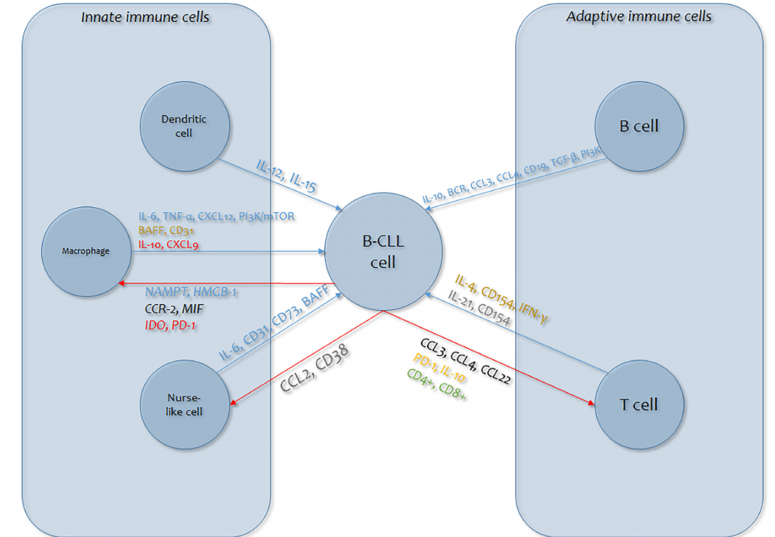
Figure 1. Graphic overview of the mechanisms of cytokine involvement in B-cell lymphocytic leukemia (B-CLL) cellular dynamics (blue arrows: e ff ects of immune cells on B-CLL cells; red arrows: B-CLL cell responses). Cytokines in plain text are those involved in the e ff ects on B-CLL cells (blue: signaling; red: immunosuppression; gold: survival; gray: proliferation); cytokines in italics are those involved in the B-CLL cell response (green: expansion; orange: exhaustion; black: chemoattraction; red: immunosuppression; blue: pro-tumor skewing; gray: immune evasion). CCL: chemokine (C-C motif) ligand; CD38: Custer of Di ff erentiation; IL: Interleukin PD-1: Programmed cell death protein 1; MIF: Macrophage migration inhibitory factor; CCR-2: C-C chemokine receptor type 2; NAMPT: Nicotinamide phosphoribosyltransferase; HMGB: High Mobility Group Box; CXCL: chemokine (C-X-C motif) ligand; BAFF: B-Cell Activating Factor; TNF: Tumour Necrosis Factor.